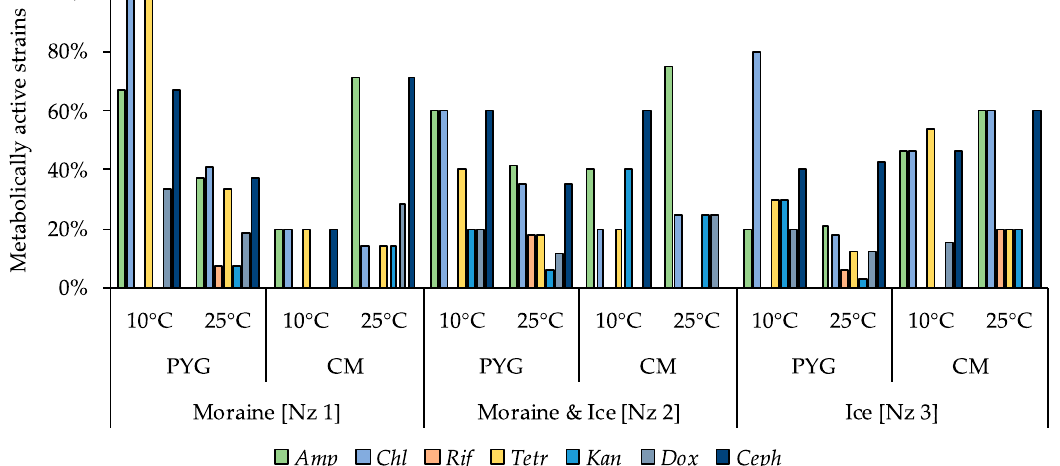
Figure 13. Isolated strains’ resistance to antibiotics. Vertical axis: proportion of the strains in the culturable community able to reproduce in considered conditions. Horizontal axis: the tested communities. Temperature and medium abbreviations indicate the isolation conditions. PYG and